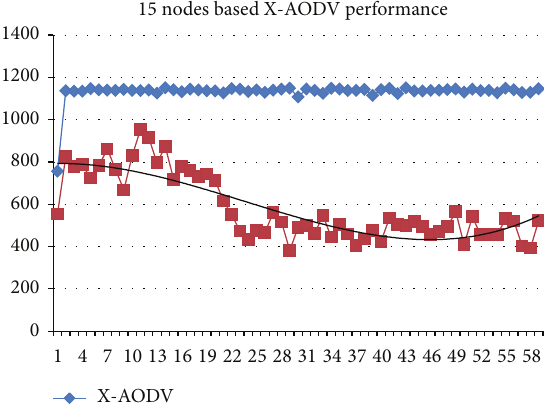
Figure 4: Cluster head selection in 15 good nodes.